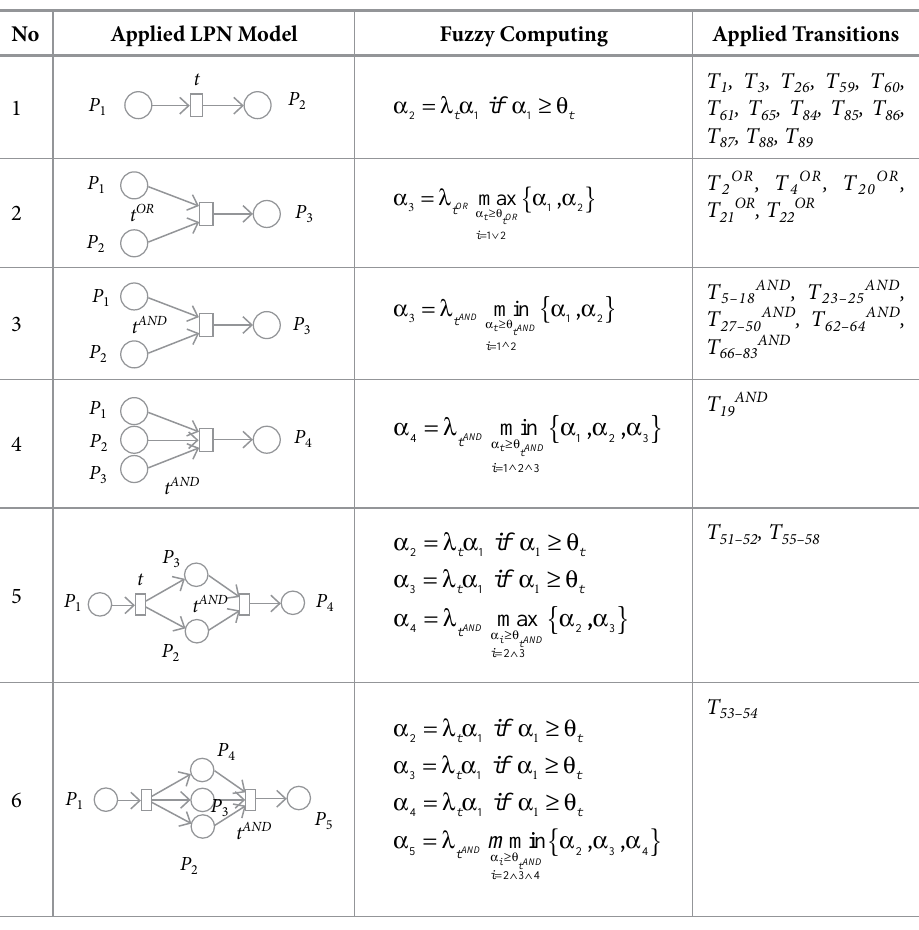
Table 2. The set of rules and corresponding transitions for recognition of degree of emotional state No Rules Transitions